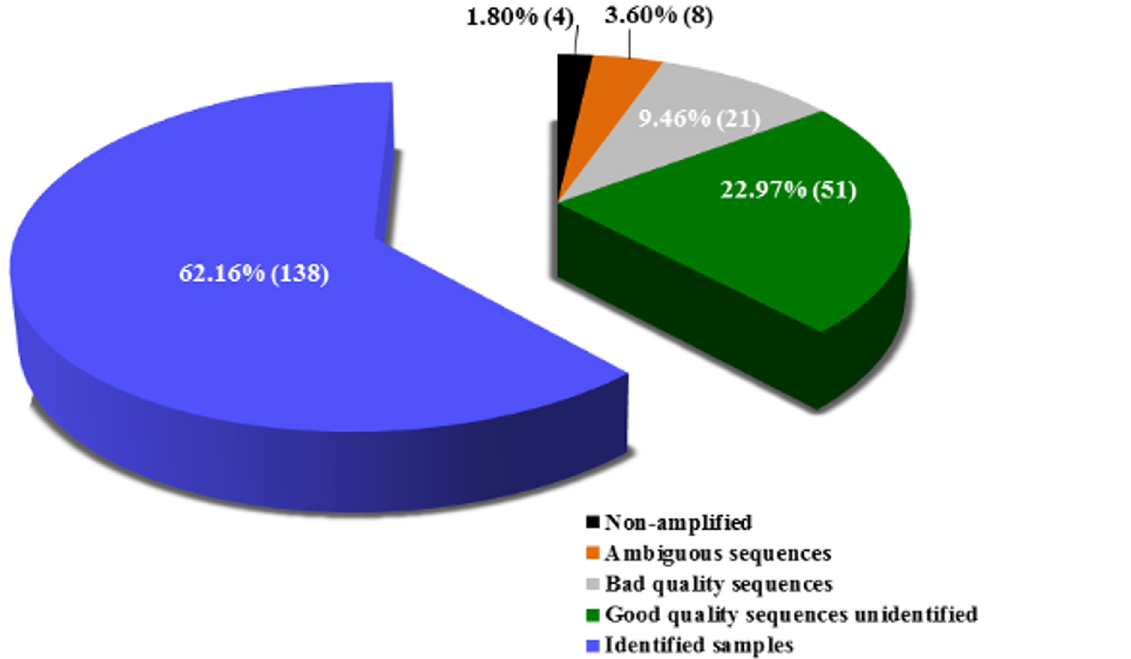
Fig 2. Percentage and absolute number of identified and unidentified samples in this